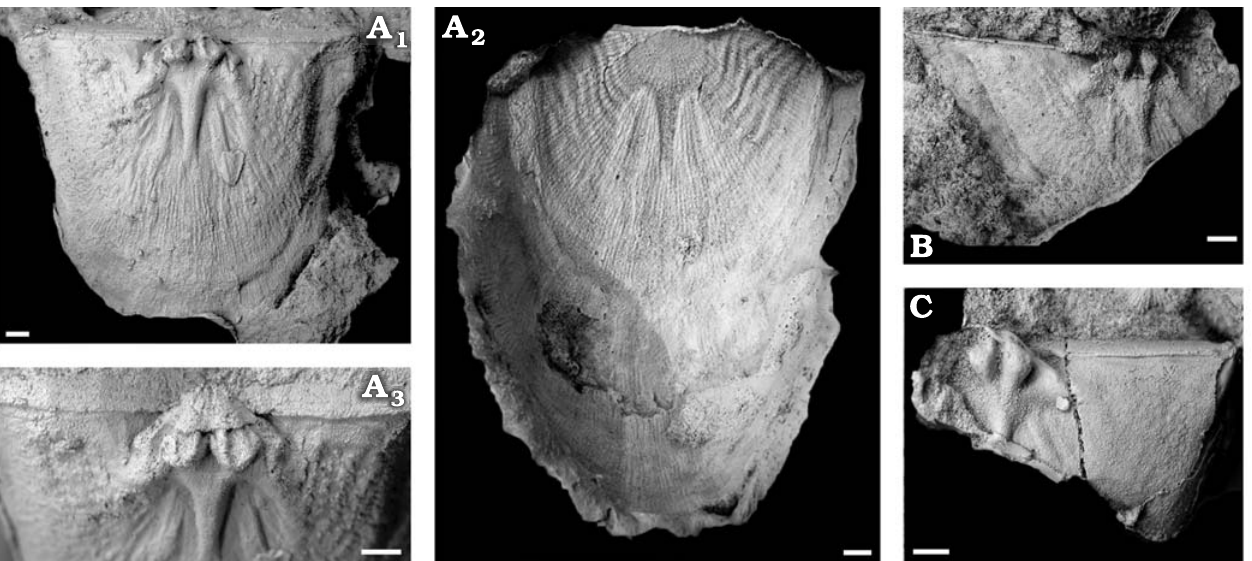
Fig. 6. Dorsal valves of rafinesquinine brachiopod Kjaerina ( Villasina ) almadenensis (Villas, 1995); middle Katian (Ka2), Upper Ordovician; “Bancos Mixtos” Formation at Almadén, Spanish Central Iberian Zone, Spain. A . MPZ 11570, holotype, latex cast of dorsal interior (A 1 ), posteroblique view (A 2 ), showing details of cardinalia, dorsal exterior (A 3 ) of a gerontic complete specimen. B . MPZ 11571, paratype, latex cast of dorsal interior of an incomplete Stratigraphic and geographic range .—Spanish Central Ibe-